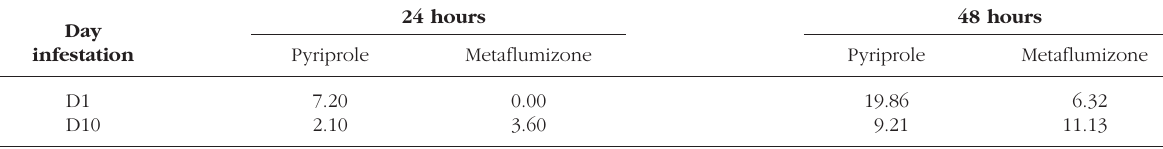
Table I. – Sandflie mortality effect